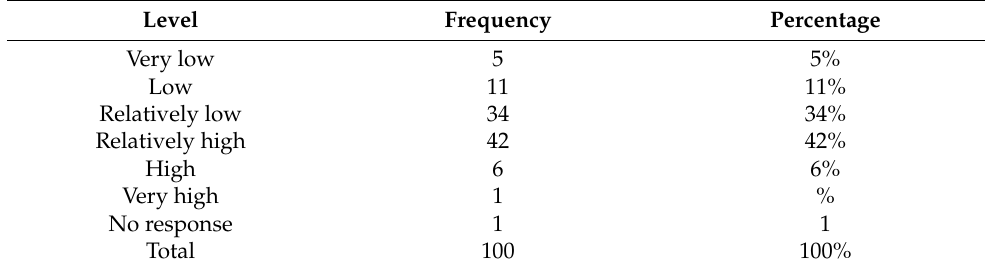
Table 7. Frequency distribution of the perception